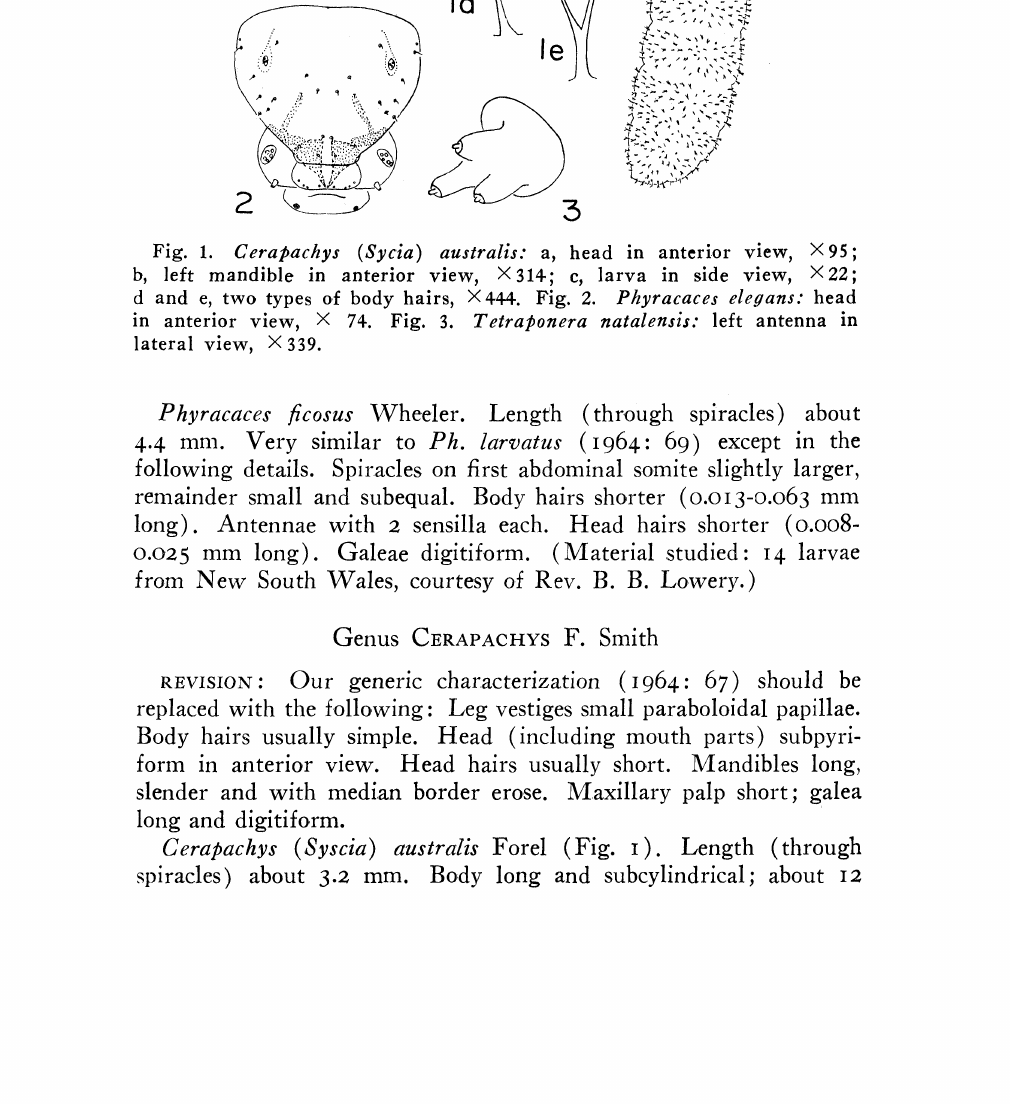
Fig. 1. Cerapachys (Sycia) australis: a, head in anterior view, X95; b, left mandible in anterior view, X314; e, larva in side view, X22; d and e, two types of body hairs, X4.44. Fig. 2. Phyracaces elegans" head in anterior view, X 74. Fig. 3. Tetraponera natalensis: left antenna in lateral view, X